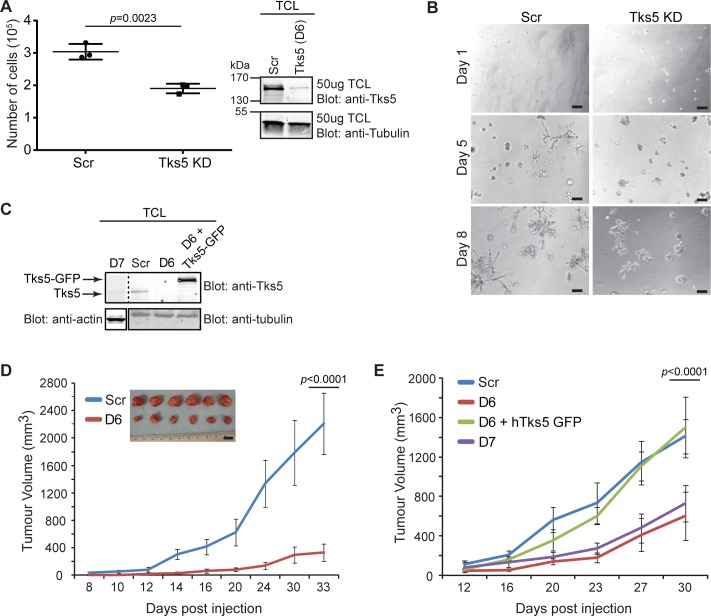
Reduced expression of Tks5 leads to decreased growth of tumor cells in vitro and in vivo.A) MDA-MB-231-Luc infected with either a scrambled (Scr) or Tks5 (D6) shRNA via lentivirus were subjected to growth assays in 3D conditions for 7–10 days. Immunoblot shows shRNA Tks5 knockdown (KD) compared to scrambled control in the cells used to evaluate growth. D6 = Tks5 knockdown clone. Experiments were performed in triplicate. B) Representative images of day 1, 5, and 8 MDA-MB-232-Luc [Scr and Tks5 KD (D6)] acini in 3D matrigel assays. Shown are low magnification phase-contrast images. Experiment was performed in triplicate. Scale bar: 100μm. C) Immunoblot: D6 and D7 represent different shRNAs tested for effective Tks5 knockdown in MDA-MB-231-Luc cells. These cell lines, as well as Scr and rescue (D6+hTks5-GFP) lines, were used for orthotopic injections in Fig 1D and 1E. D) Control (Scr) and Tks5 (D6) KD clones were inoculated in the mammary fat pad of SCID-Beige mice. Tumor volumes were measured every 2–3 days as described in Materials and Methods and tumors were allowed to grow to a final volume of approximately 2cm3. n = 20 mice per tumor type. Experiments were performed in triplicate (at least). Inset: Photographs of 6 tumors per group at the day of dissection (endpoint of experiment). Scale bar: 1cm. Tumor images are representative for all experiments performed. E) Control (Scr), Tks5 (D6 and D7) KD clones, and a Tks5 rescue clone (D6+ hTks5-GFP) were inoculated in the mammary fat pad of SCID-Beige mice. Tumor volumes were measured as in Fig 1D. n = 5 mice per tumor type. Experiments were performed in triplicate (at least). Data are expressed as mean ± SD. One-way ANOVA or a Student’s t test was used to calculate p values.